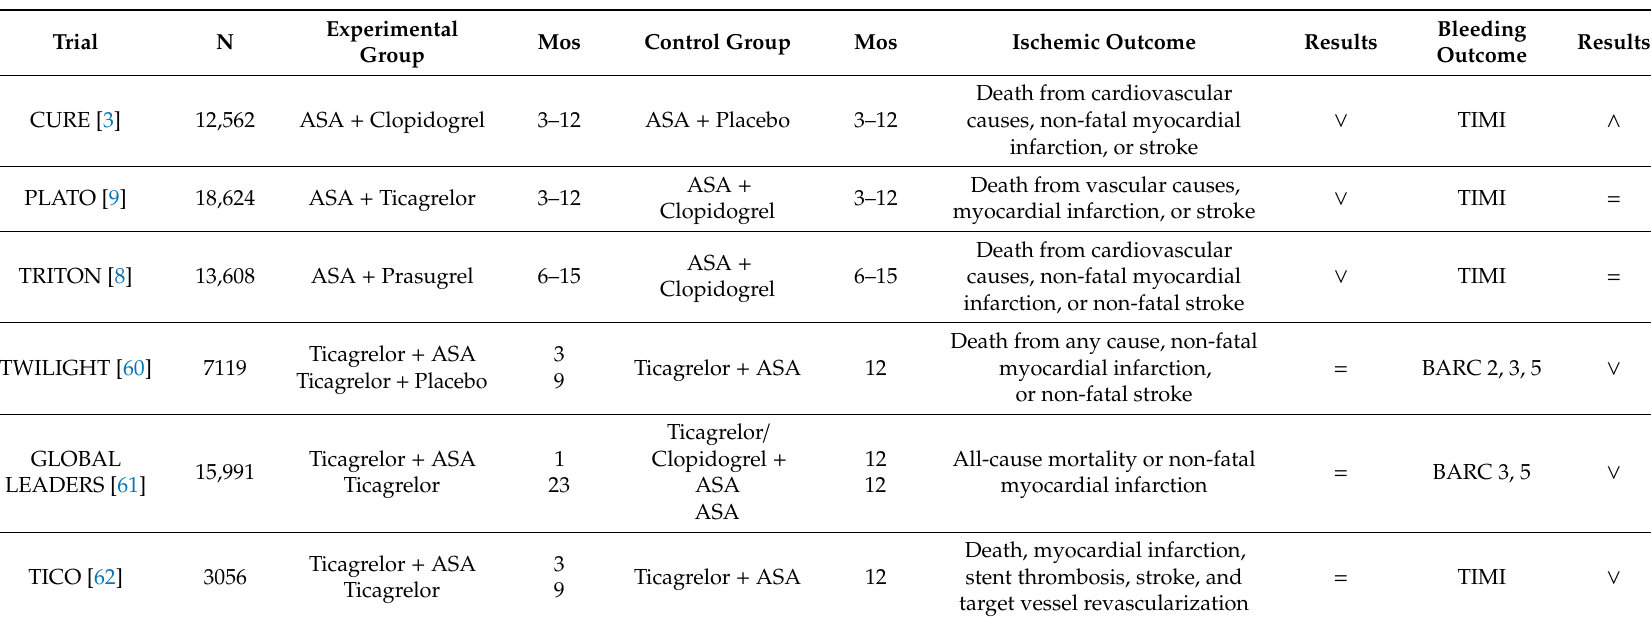
Table 3. Randomized controlled trials comparing di ff erent durations of dual antiplatelet therapy. ASA, aspirin; BARC, Bleeding Academic Research Consortium; Mos, months; TIMI, Thrombolysis in Myocardial Infarction; ∨ , statistically significant reduction in outcome in experimental group compared to control group; ∧ , statistically significant increase in outcome in experimental group compared to control group; = , no statistical di ff erence in outcome between the two